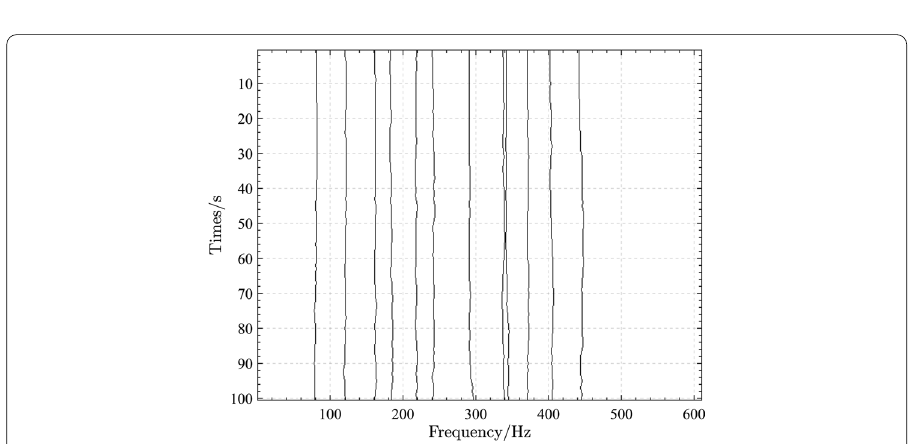
Fig. 21 Extraction results of proposed algorithm of second set of sea-trial